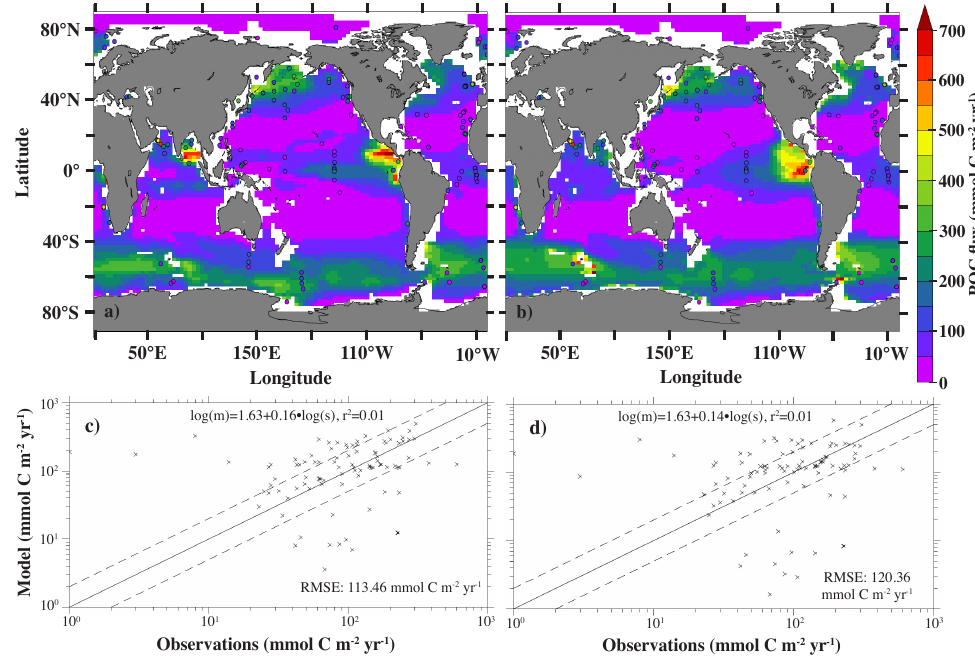
Figure 21 Fig. 20. Simulated fluxes of POC at 2km with the (a) new and (b) old models. Observed fluxes from Honjo et al. (2008) are plotted as filled circles. Statistical comparisons with the observations are shown in (c) and (d) for the new and old model versions, respectively.